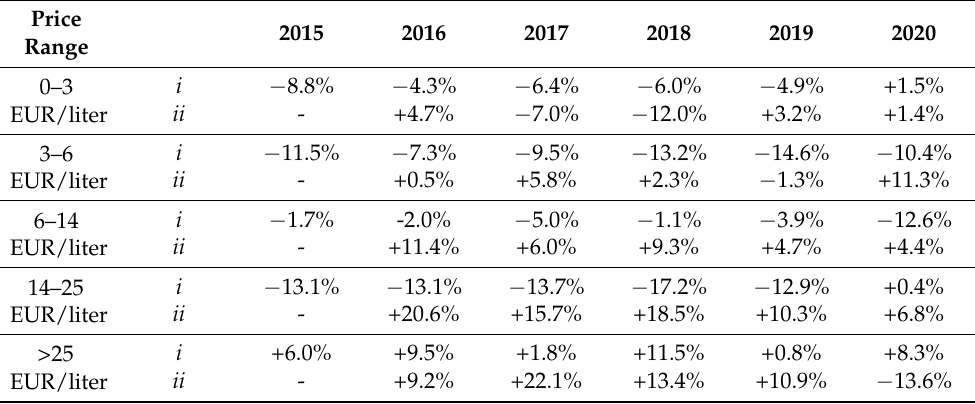
Table 9. Percentage change of wine sales in value in 0.75 liter bottles by price range compared to the previous period: for each year, ( i ) the variation of b2 compared to b1, and ( ii ) the variation of b2 compared to b2 of the previous year.